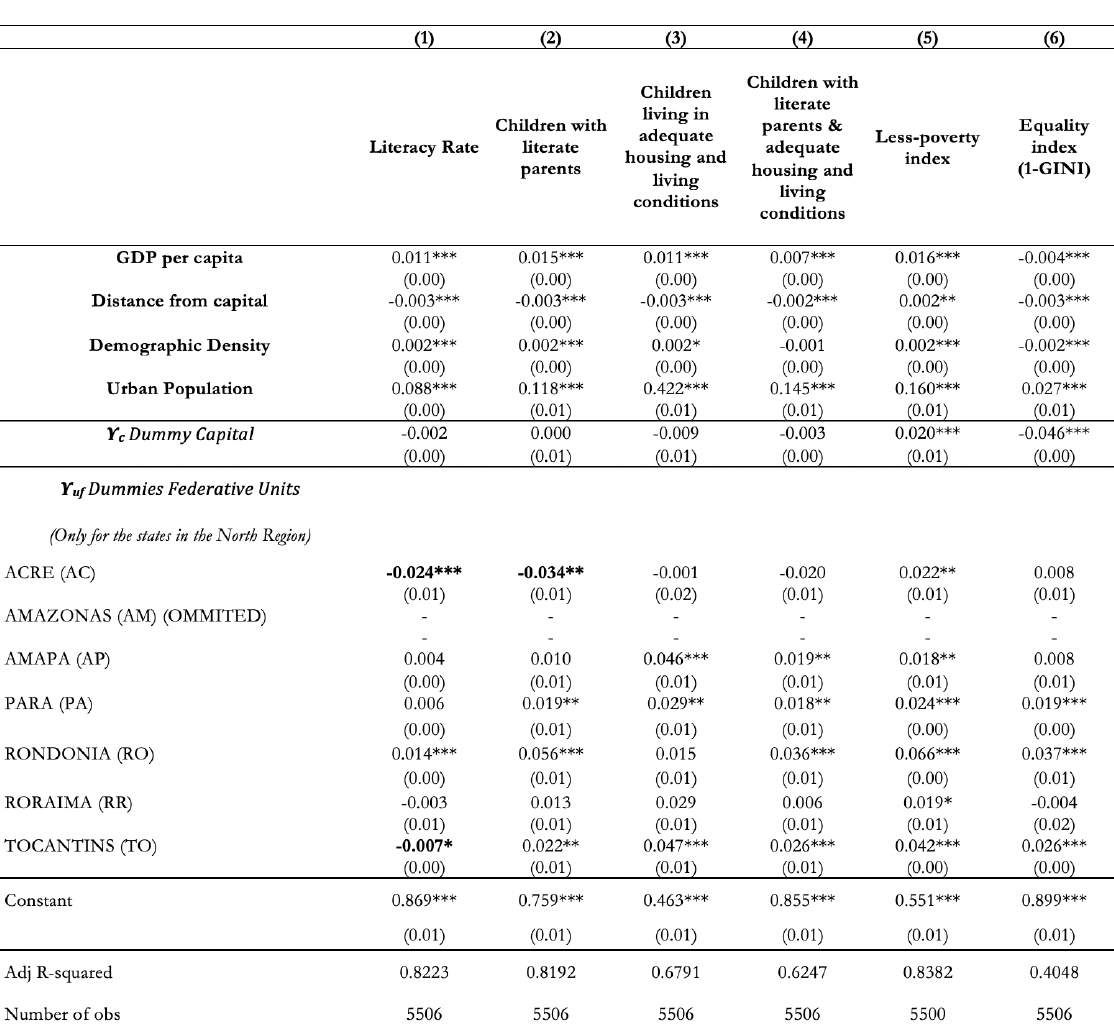
Table 3: Social Regressions MODEL